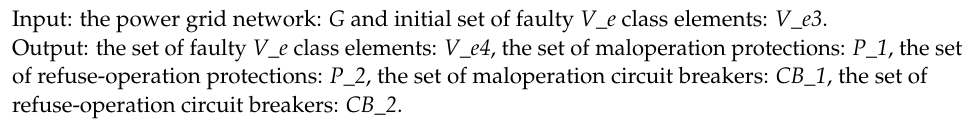
Algorithm 3 Faulty elements determination and operation status analysis of related